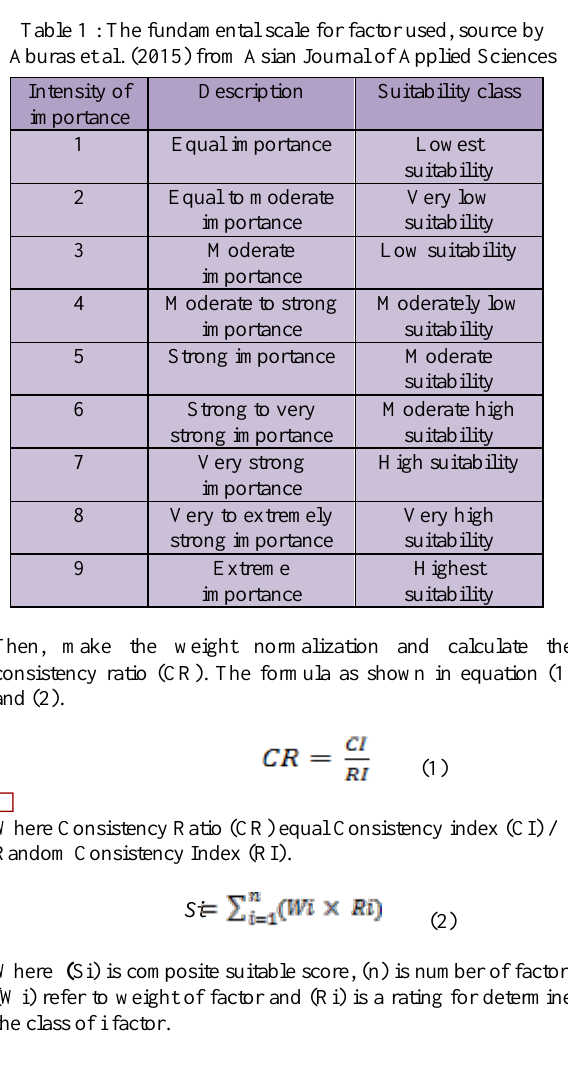
Figure 1. Simple weighting process implemented in GIS adopted from (Malczewski 2009)